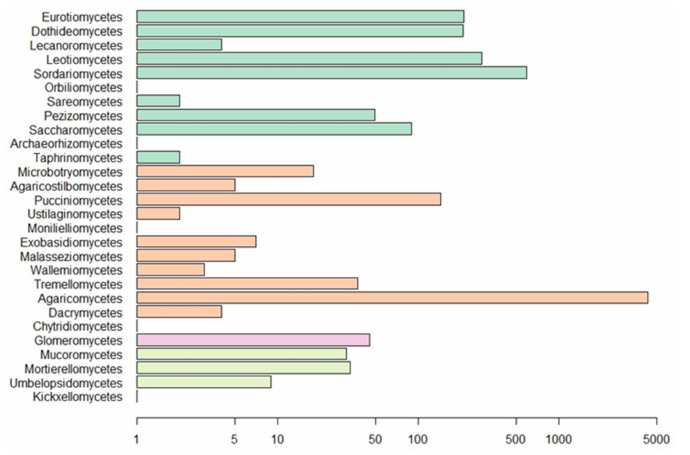
Figure 4. Number of observations for fungal classes in our dataset. Scale is logarithmic. Classes are colored by phylum as in Figure 3.